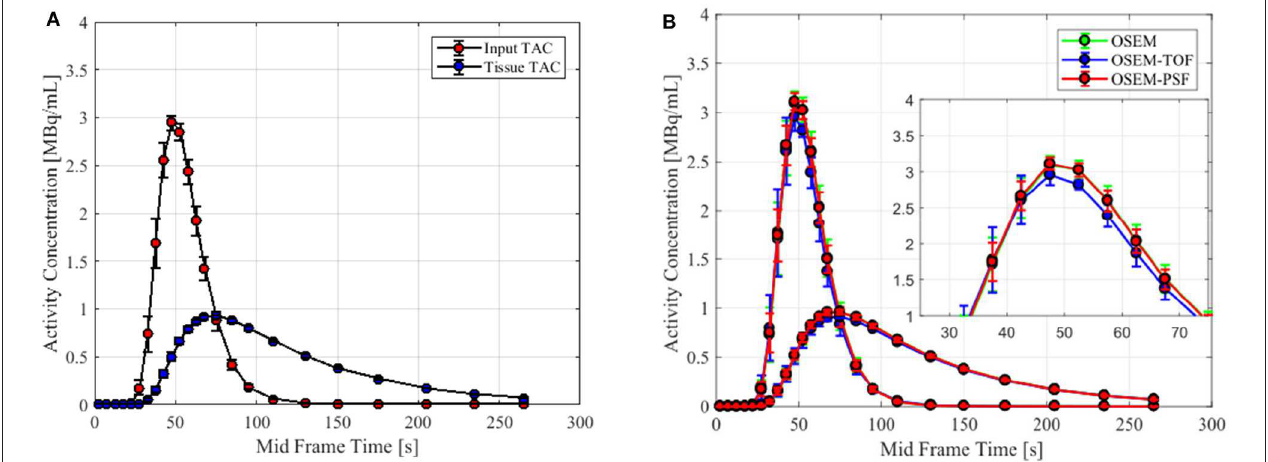
FIGURE 2 | Input and tissue time-activity curves (TAC) presented for the reconstructions. In (A) is shown the TACs of the Q.Clear reconstruction, similar to OSEM-TOF-PSF reconstructions with different matrix sizes and GFS values and thus, are not shown separately. In (B) the TACs of the OSEM, OSEM-TOF, and OSEM-PSF reconstructions are shown with a zoom-in to the input peak. Difference in shape and amplitude between the TACS of the reconstructions is seen. The 50s delay has not been included in the